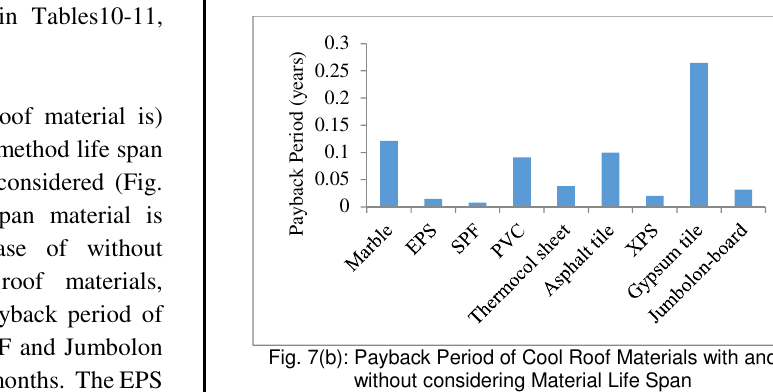
Fig. 7(a): Payback Period of Cool Roof Materials without considering Material Life Span